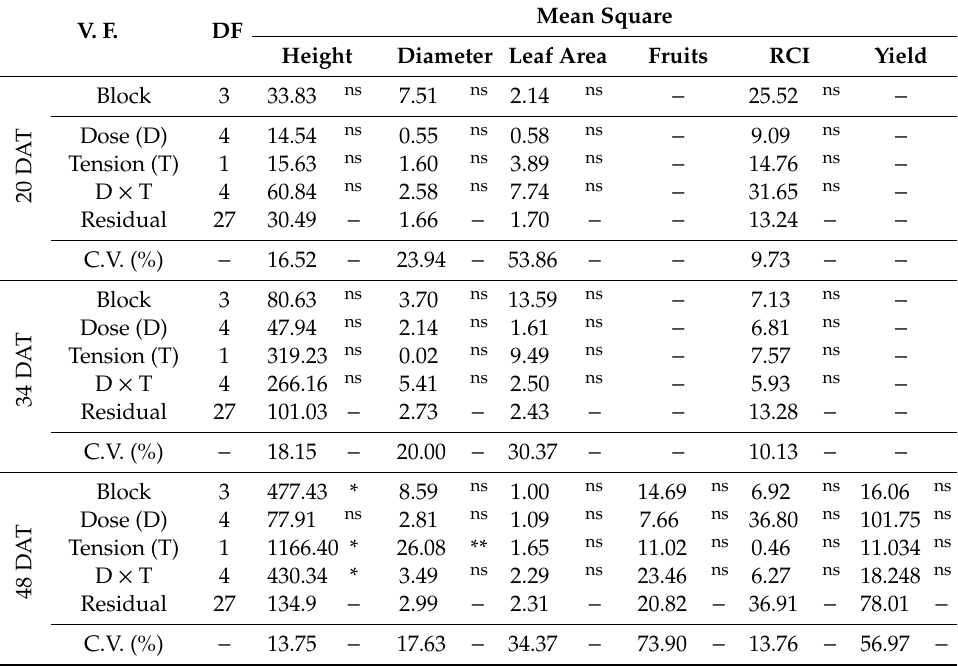
Table 1. ANOVA summary of the biometric variables, namely, the stem height (cm), diameter (mm), leaf area (cm 2 ), fruits, relative chlorophyll index (RCI), and yield (t ha − 1 ) with application of five doses of Si (0.0 (control), 1.0, 2.0, 3.0 and 4.0 g L − 1 ) and two soil water potentials ( − 30 and − 60 kPa), at 20, 34, and 48 days after transplantation